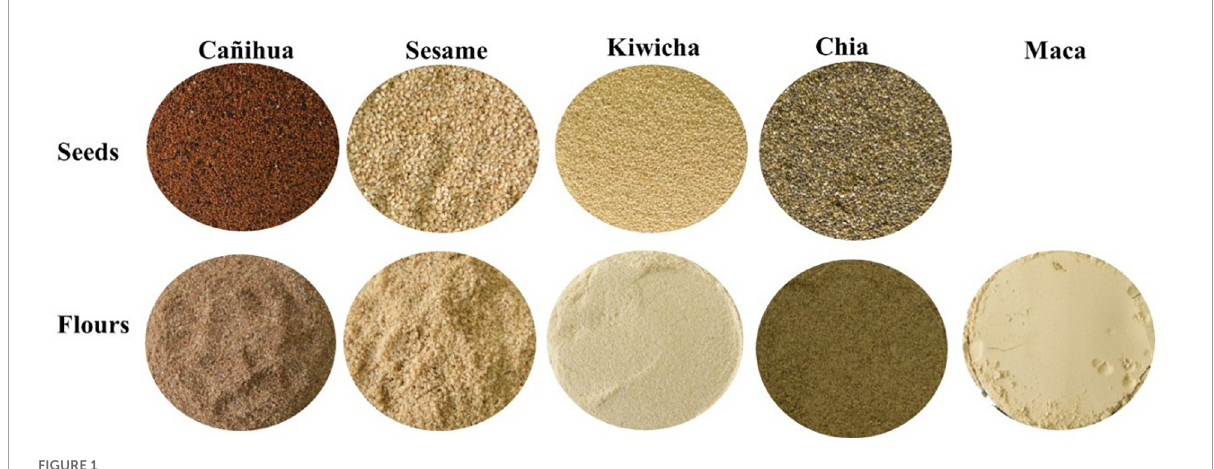
FIGURE1 Seeds and flours used in the